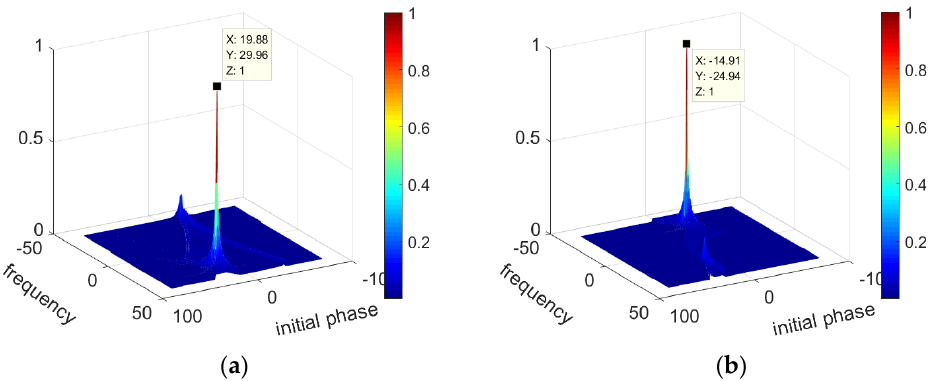
Figure 5. Results of GSCFT: ( a ) using the estimated parameters of component 1 to compensate for the echo; ( b ) using the estimated parameters of component 2 to compensate for the echo.